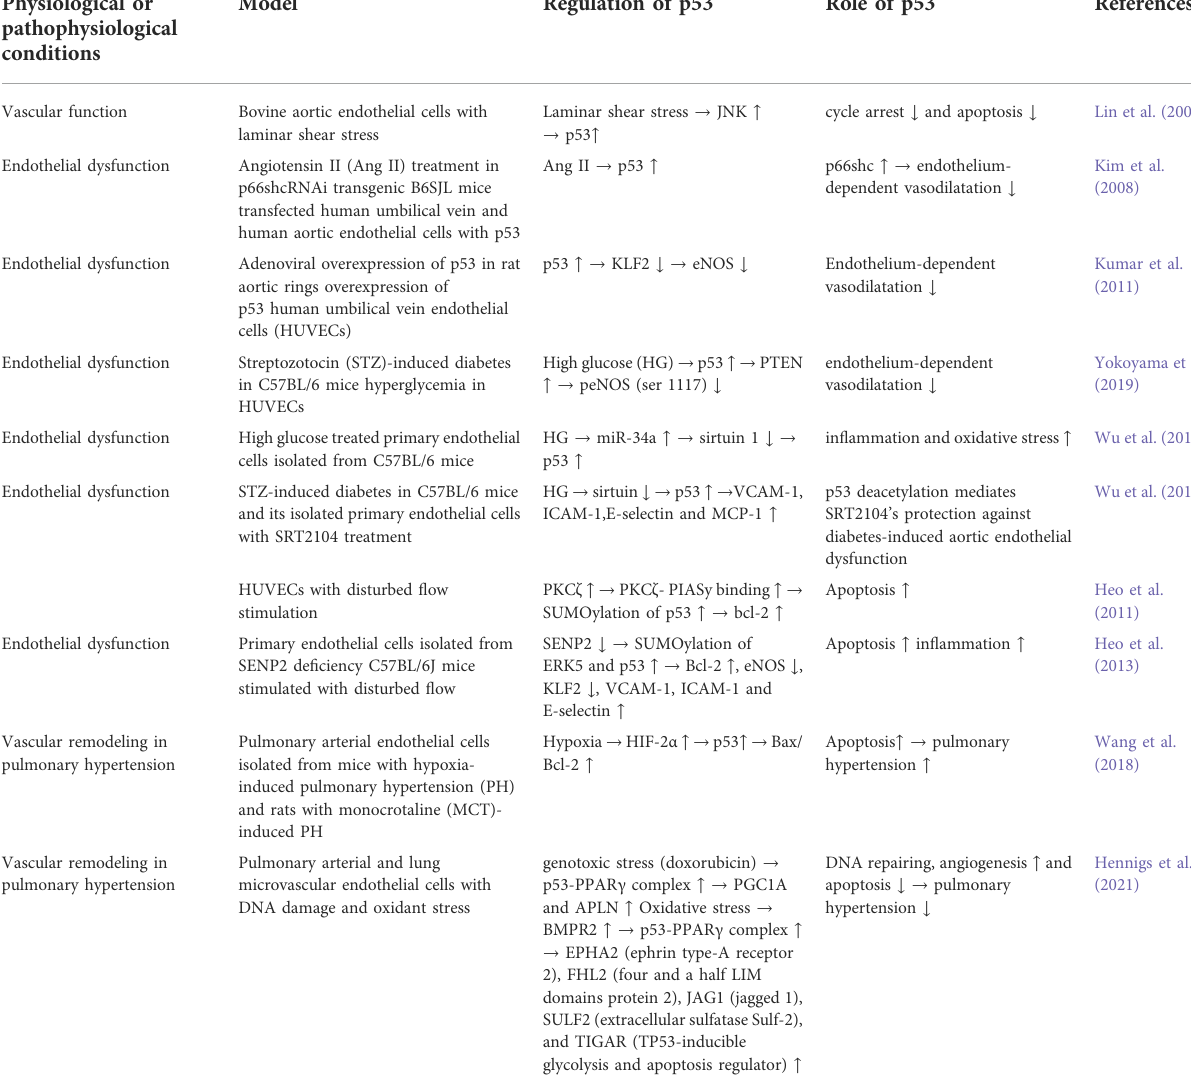
TABLE 1 Summary of regulation of p53 in endothelial cell under different physiological or pathophysiological